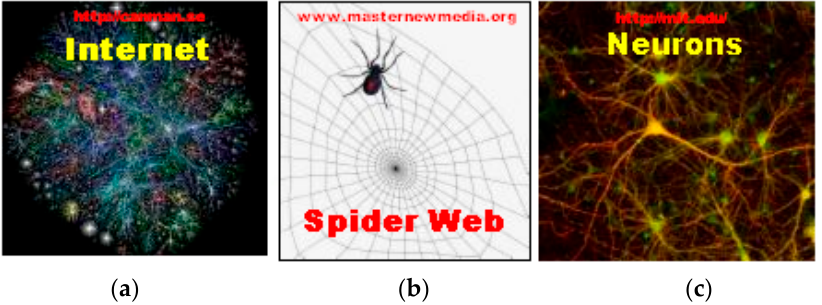
Figure 2. Interconnectivities of the internet, spider web and neurons: ( a ) Man’s vision; ( b ) Insect made; ( c ) Nature